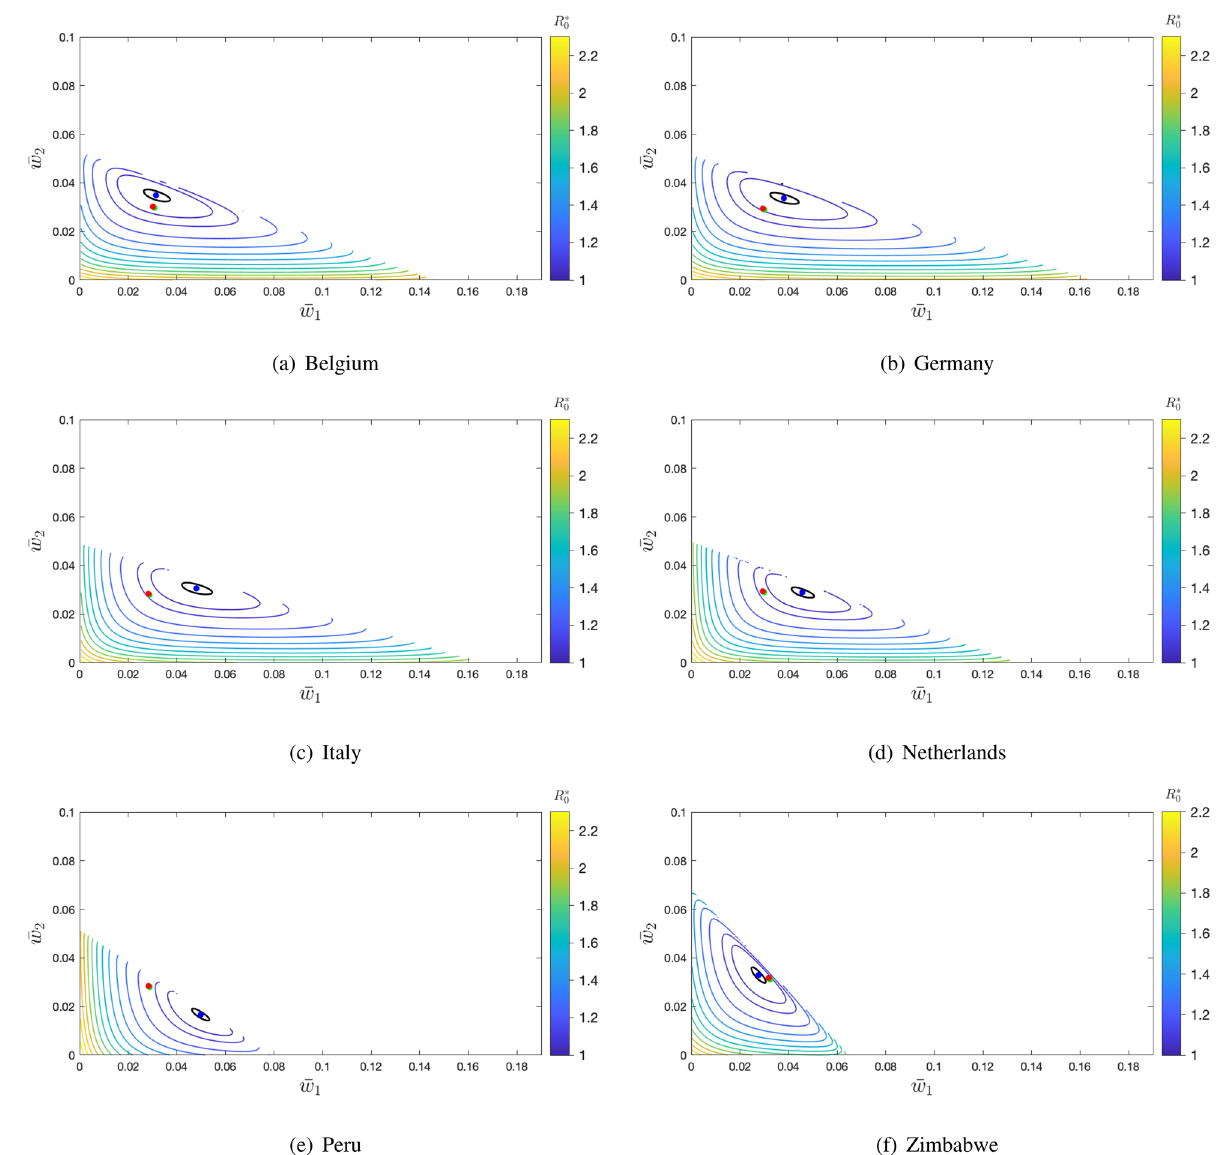
Figure 4. Contour levels of R ∗ 0 ( ¯ w 1 , ¯ w 2 ) at the DFE of system (1) with p i = 1 ( i = 1, 2, 3 ) and for ¯ w = ¯ w 0 , a value for which R 0 ≈ 0.996 (see Table 3). Black level curve corresponds to R ∗ 0 = 1 . Blue point: Minimum of R ∗ 0 . Red point: R ∗ 0 under uniformly random vaccination ( ¯ w 1 = ¯ w 2 = ¯ w c ). Green point: R ∗ 0 at the disease-free equilibrium with the maximum vaccination coverage. Parameters: γ 1 = 1 , γ 2 = 1 , γ 3 = 0.9 , δ v 1 = 1 / 40 , δ v 2 = 1 / 52 , δ v 3 = 1 / 40 . For each country, β is scaled such that R 0 = 2.5 in the absence of vaccinated individuals.